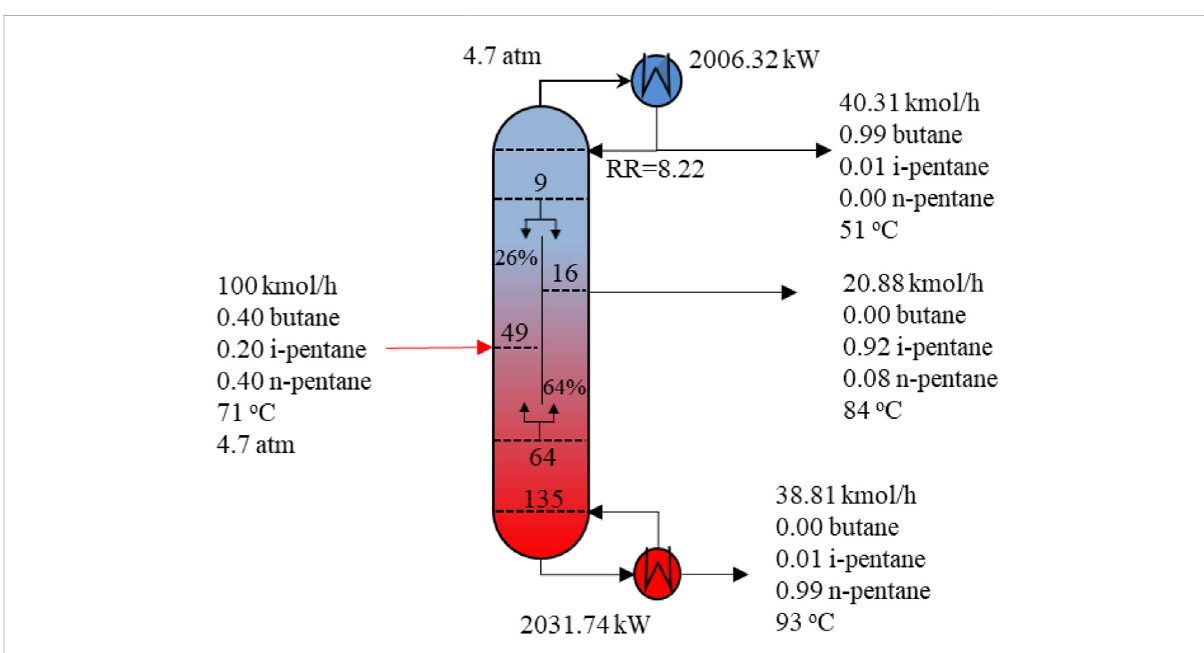
FIGURE 7 Optimal design and operating conditions of DWC column for Example